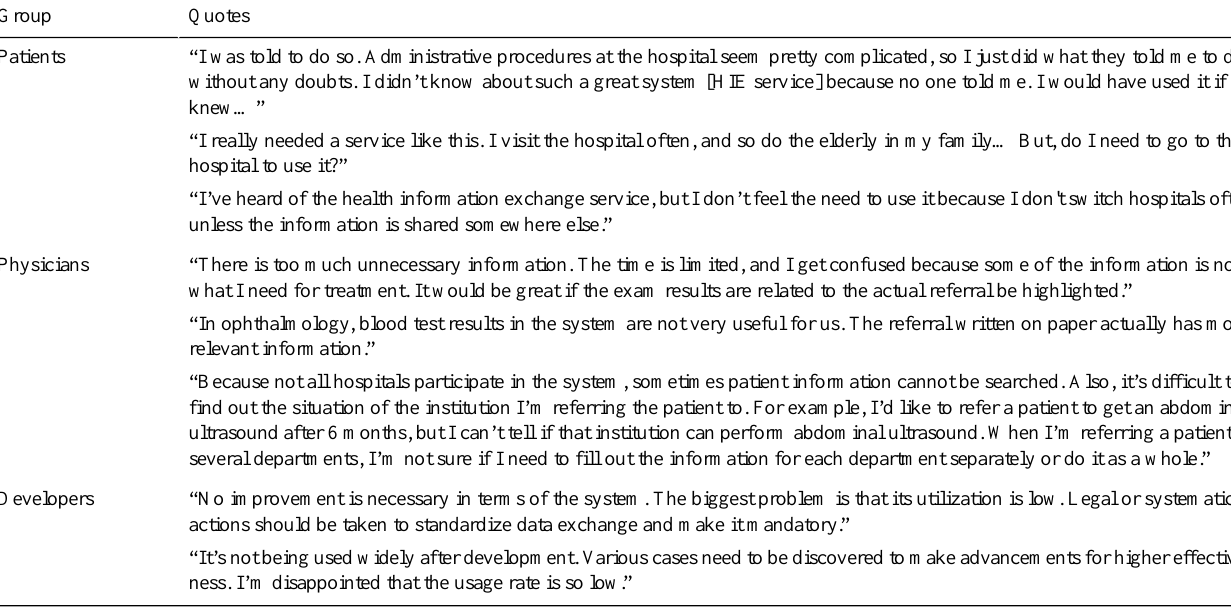
Table 4. Opinions about existing problems in hospital information exchange